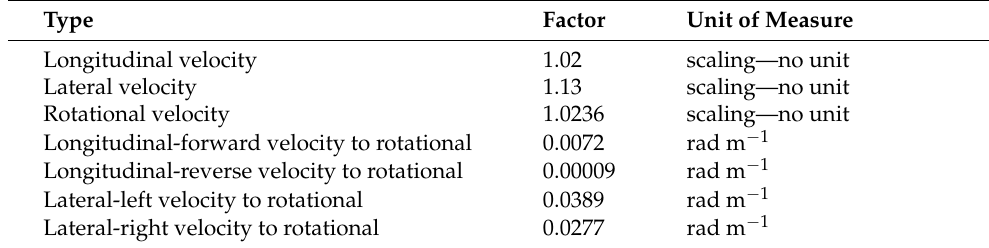
Table 2. Correction